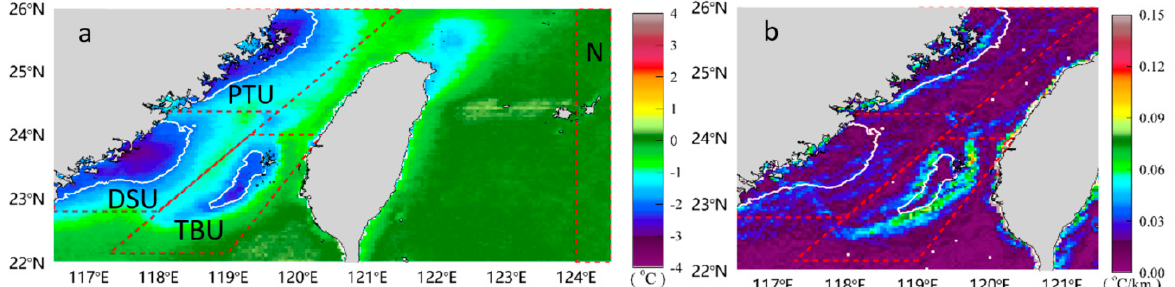
Figure 2. The spatial distribution of the difference in SST between the TWS and non − upwelling zone ( a ) and the SST gradient ( b ) of multi − year average summer sea surface temperature for 1982–2019 in the TWS. The calculation domain for the Pingtan upwelling (PTU), Dongshan upwelling (DSU), Taiwan Bank upwelling (TBU), and non − upwelling zone (N) are illustrated as red dashed lines on ( a ). The overlaid white contours represent a SST difference of − 2 ◦ C. Upwelling intensity ( R ) is defined following the methods from Kuo et al. [38] and Shang et al.